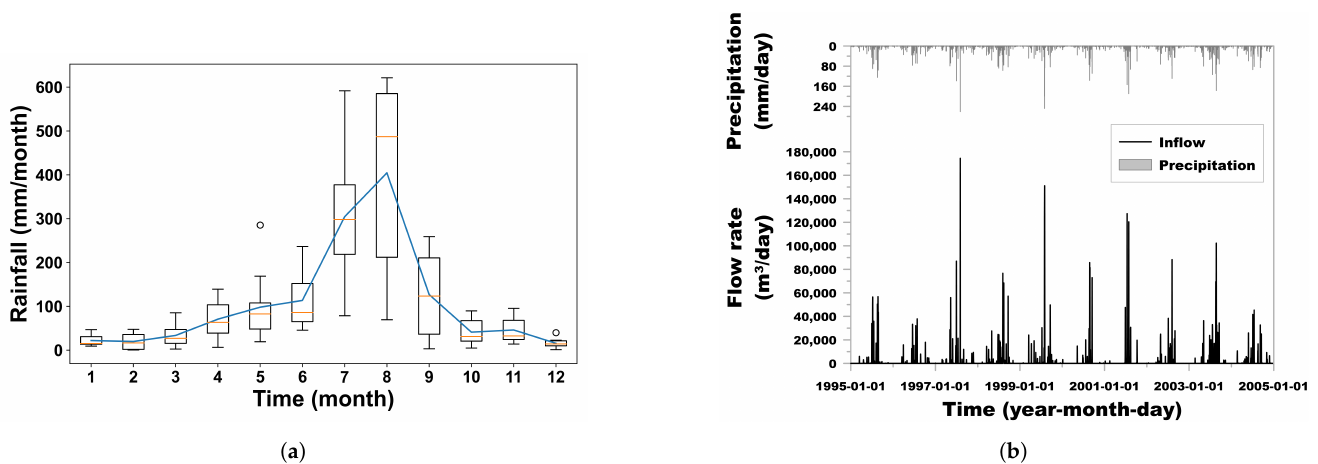
Figure 2. Rainfall–runoff time series data in the study area (1995–2004): ( a ) box and whisker plot with monthly distributions of rainfall; ( b ) result of rainfall–runoff simulation.